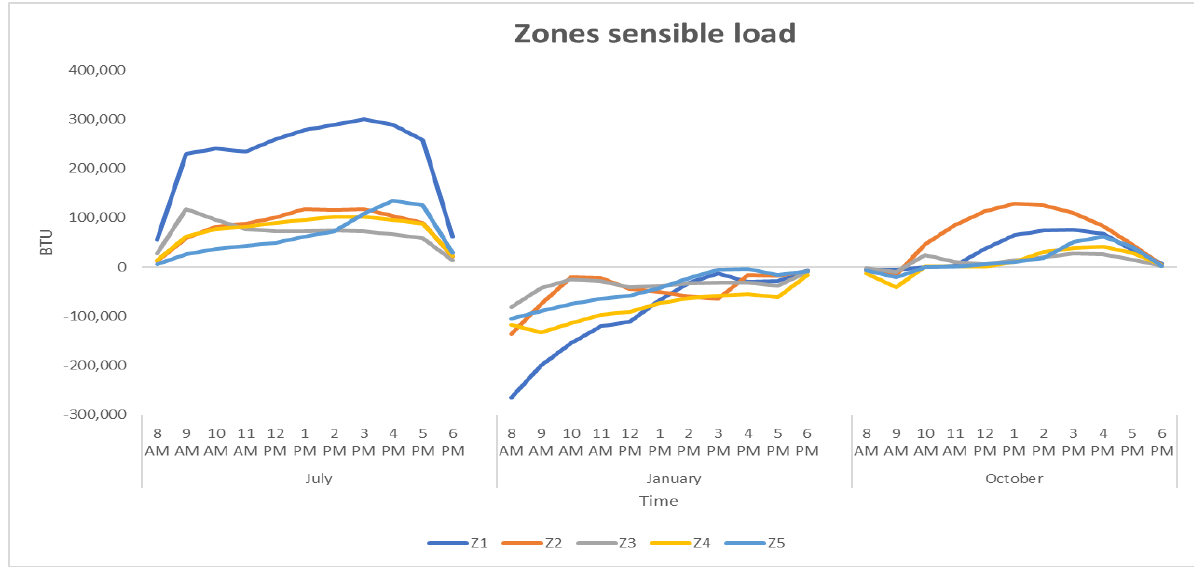
Figure 9. The five zones sensible load in BTU for each day being analyzed.